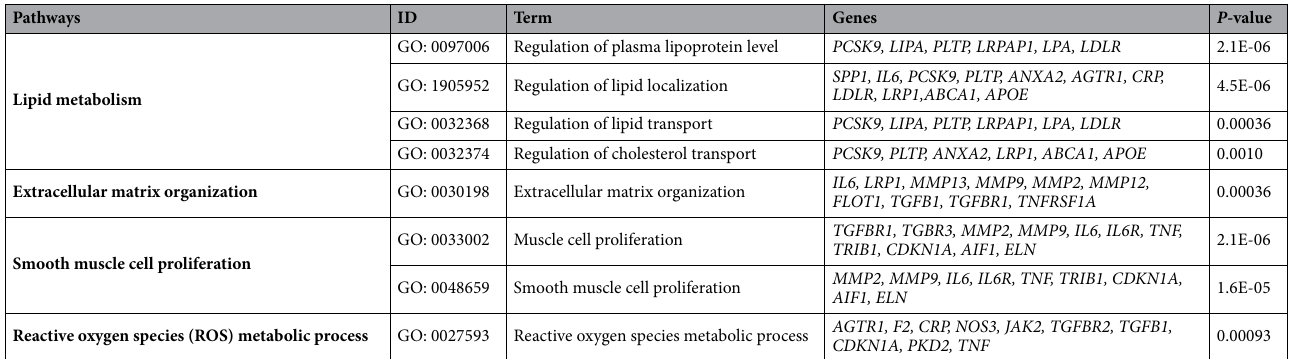
Table 4. The enriched Gene ontology (GO) term and pathways from the SNPs associated gene queries according to the GENEmania plugin of Cytoscape. PCSK9, Proprotein Convertase Subtilisin/Kexin type 9; LIPA, Lipase A; PLTP, Phospholipid Transfer Protein; LRPAP1, Low Density Lipoprotein Receptor Related Protein Associated Protein 1; LPA, Lipoprotein A; LDLR, Low Density Lipoprotein Receptor; SPP1, Secreted Phosphoprotein 1; IL6, Interleukin 6; ANXA2, Annexin A2; AGTR1, Angiotensin II Receptor Type 1; CRP, C Reactive Protein; ABCA1, ATP Binding Cassette Subfamily A Member 1; APOE, Apolipoprotein E; MMP2, Matrix Metallopeptidase 2; MMP3, Matrix Metallopeptidase 3; MMP9, Matrix Metallopeptidase 9; MMP13, Matrix Metallopeptidase 13; LRP1, Low Density Lipoprotein Receptor-related Protein 1; FLOT1,